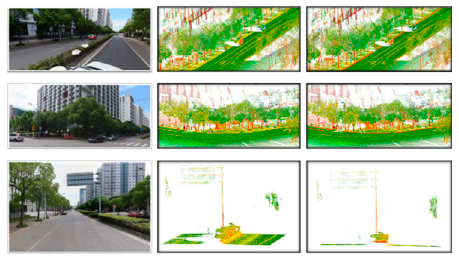
Figure 12. A visual example of study sites in three complex scenes.